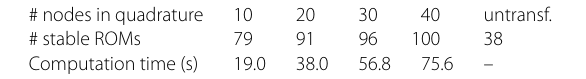
Table 2 Number of asymptotically stable systems out of 100 ROMs with dimensions 1, ... ,100 and computation times for projection matrix (10) in stabilization using frequency domain integrals for mass-spring-damper example # nodes in quadrature 10 20 30 40 untransf. # stable ROMs 79 91 96 100 38 Computation time (s) 19.0 38.0 56.8 75.6